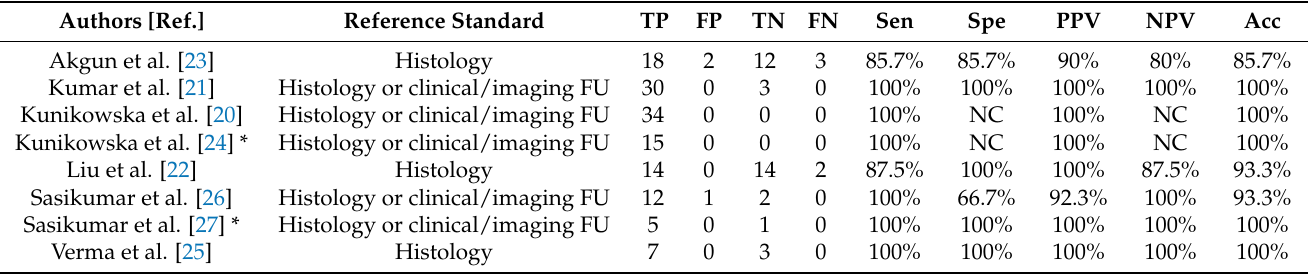
Table 4. Diagnostic accuracy data of the index test in high-grade gliomas on a patient-based analysis. Authors